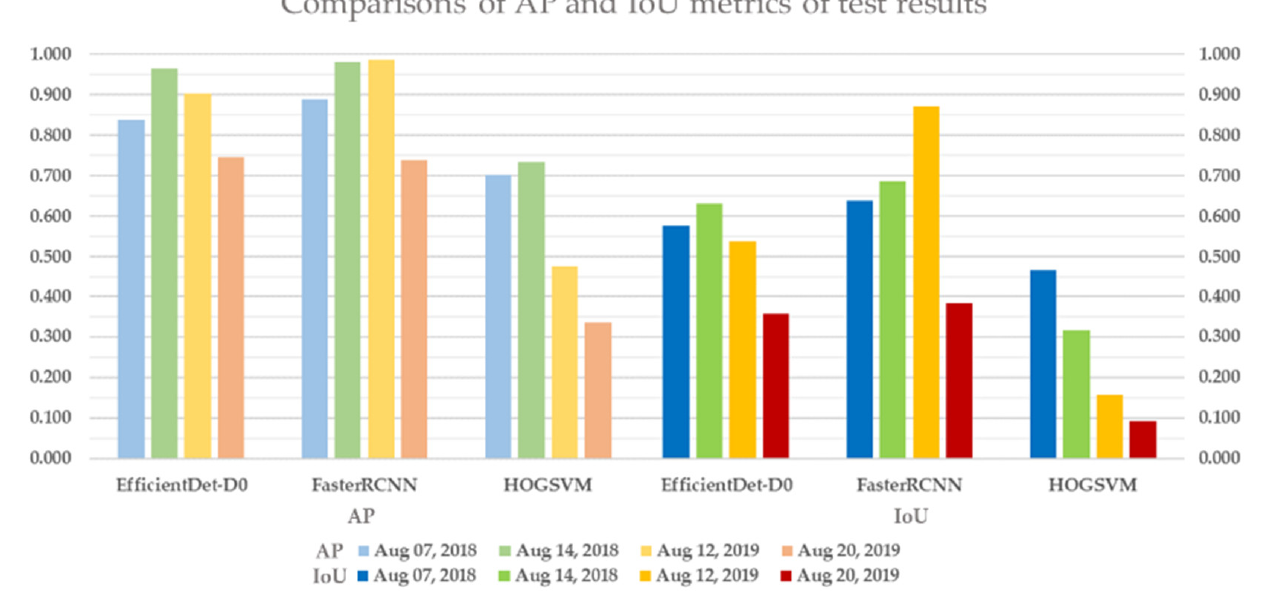
Figure 15. A vertical chart comparing evaluation results with AP and IoU metrics.